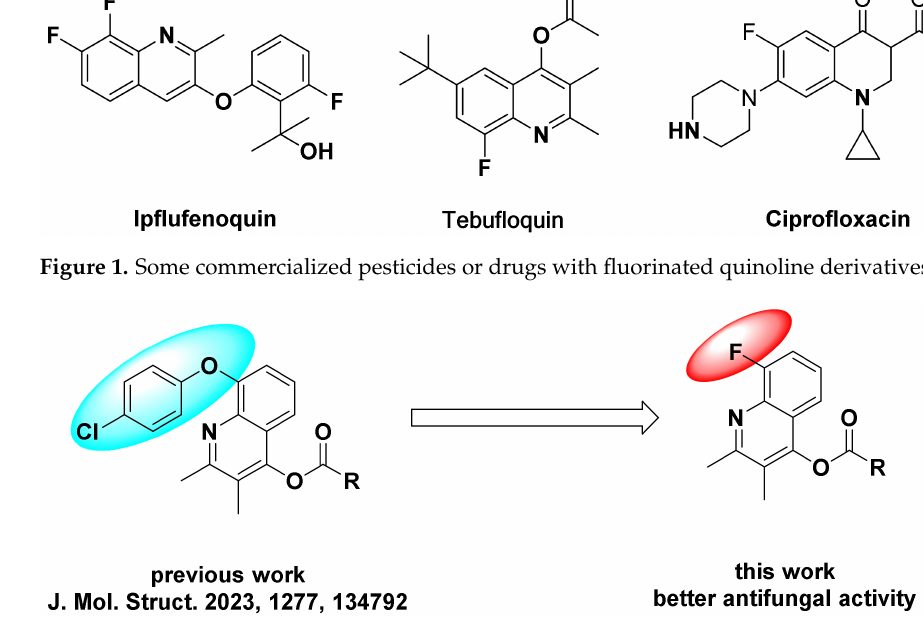
Figure 2. Design strategy of the title compounds 2a – 2p [32].